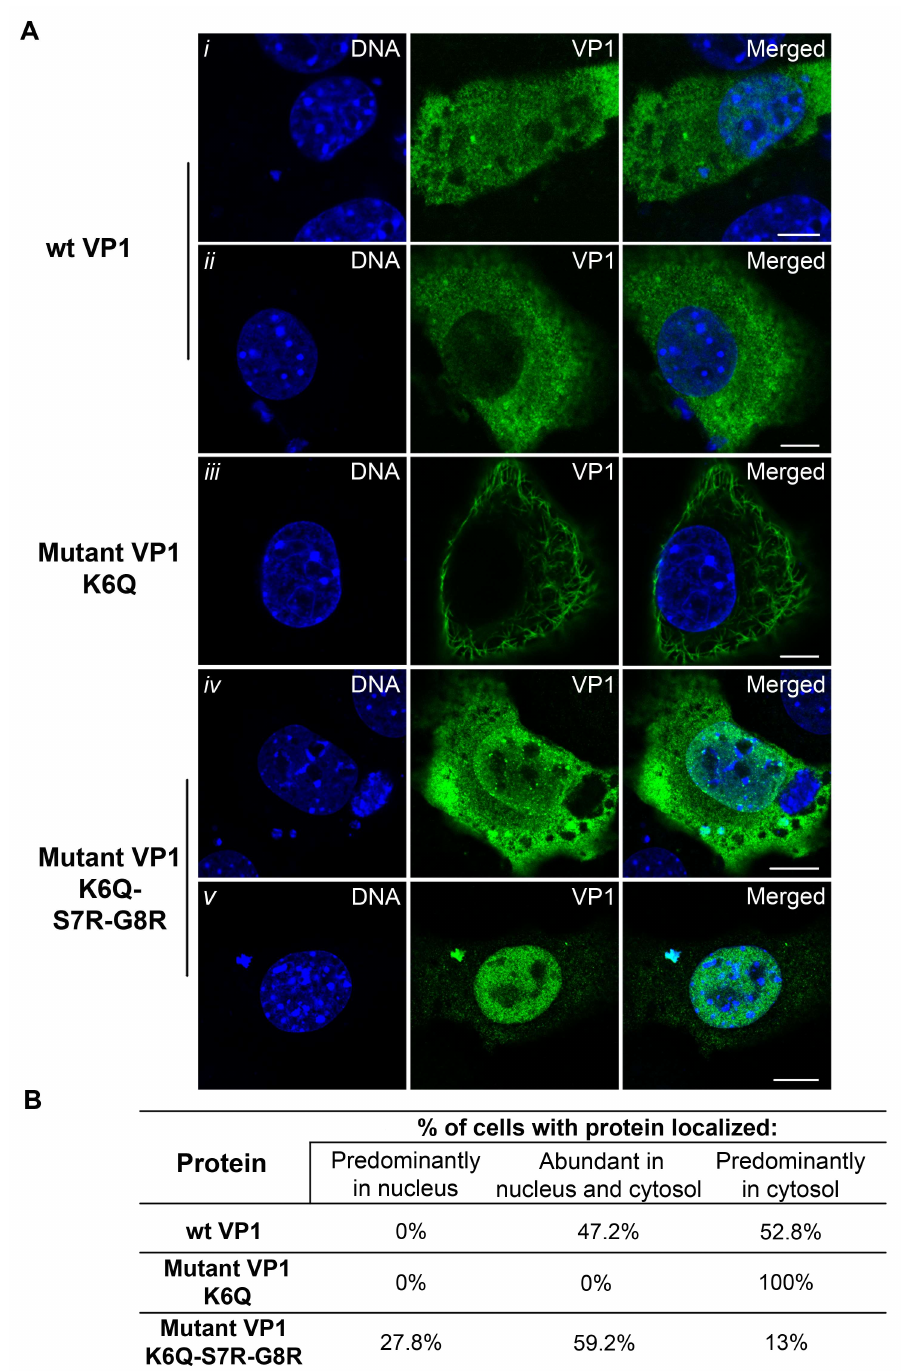
Figure 7. Subcellular distribution of wild type or mutated VP1 capsid proteins. Confocal sections of 3T3 cells expressing wt or mutated VP1 proteins. Cells were fixed at 24 hpt and stained with anti-VP1 antibody (green) and DNA by DAPI (blue) ( A ); For analysis of subcellular distribution of wt ( i – ii ) or mutated proteins ( iii – v ), 50 cells were examined for each variant. Bars 5 µ m. Scores are given as percentage ( B